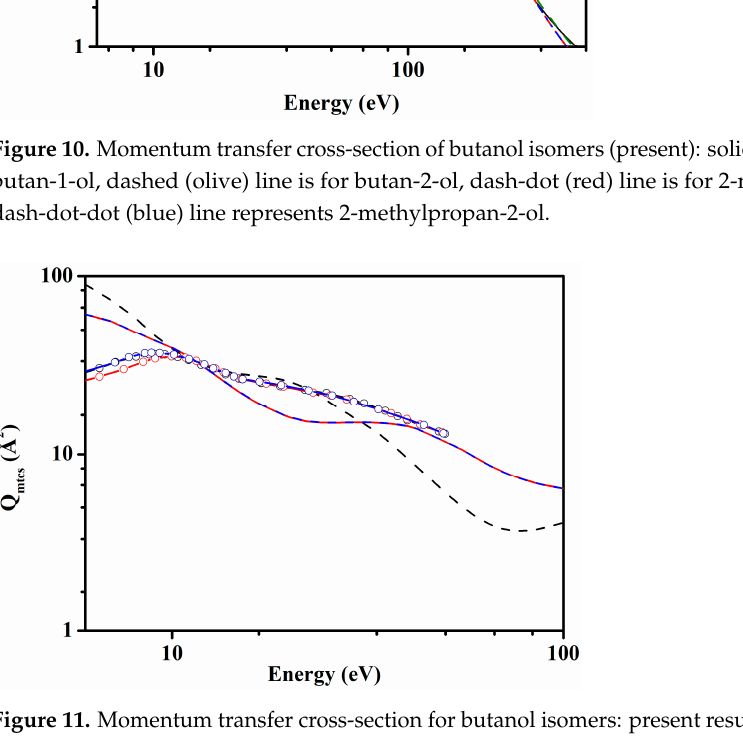
Figure 12. Momentum transfer cross-section of pentan-1-ol: solid (black) line shows present re- sults, dashed (blue) lines show calculated (SE) results of de Oliviera et al. and dash-dot (red) line represents calculated (SEP) results of de Oliviera et al.